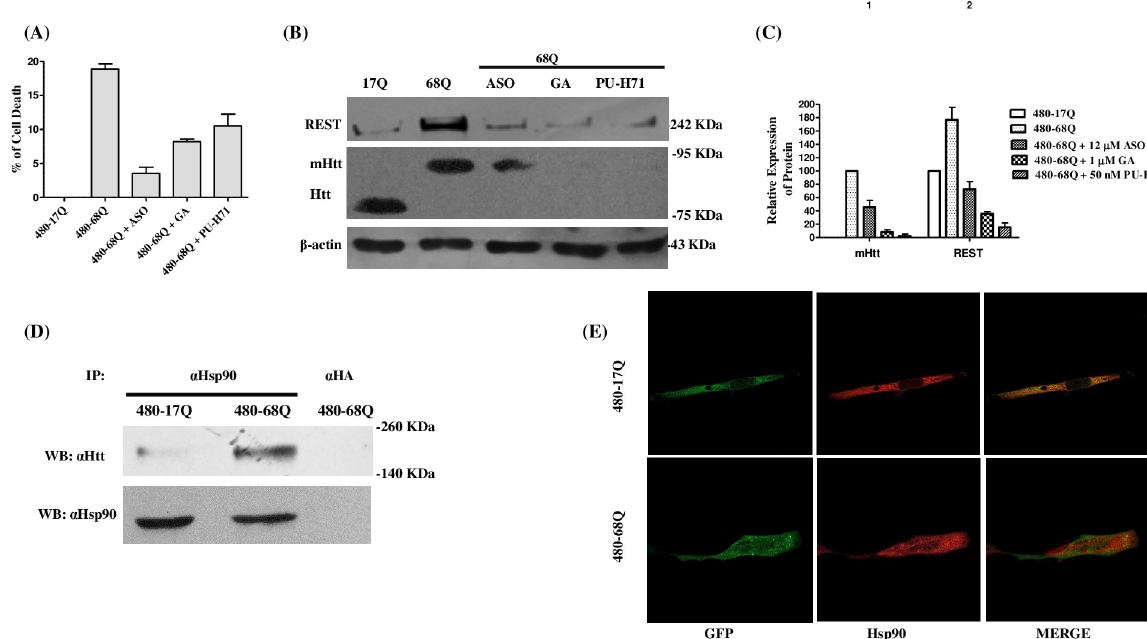
Fig 5. Inhibition of Hsp90 induces mutant huntingtin degradation. (A) Differentiated SH-SY5Y cells transiently transfected with expression vector GFP-480-68Q were treated at 6 h with GA (1 μ M) or PU-H71 (50 nM) or were transiently co-transfected with vector GFP-480-Htt68Q and Hsp90 ASO (12 μ M). After 24 h, cell death was analyzed. (B) Cells lysates were analyzed by Western blotting. (C) Protein levels were compared to those of control cells solely transfected with expression vector GFP-480-17Q. β -actin was used to assess total protein loading. (D) Differentiated SH-SY5Y cell lysates were prepared in lysis buffer at 15 h after their transfection with expression vector GFP-480-17Q or GFP-480- 68Q and were subjected to immunoprecipitation ( IP ) with anti-Hsp90 antibody or anti-HA antibody as a control. Then, the membrane was blotted with anti-Htt antibody (upper), and the membrane was stripped and blotted with anti-Hsp90 (lower). (E) Protein interactions were analyzed by confocal microscopy. The staining of exogenous nHTT or mHtt (green) and Hsp90 (red) were merged. Hsp90 is observed co- localizing with